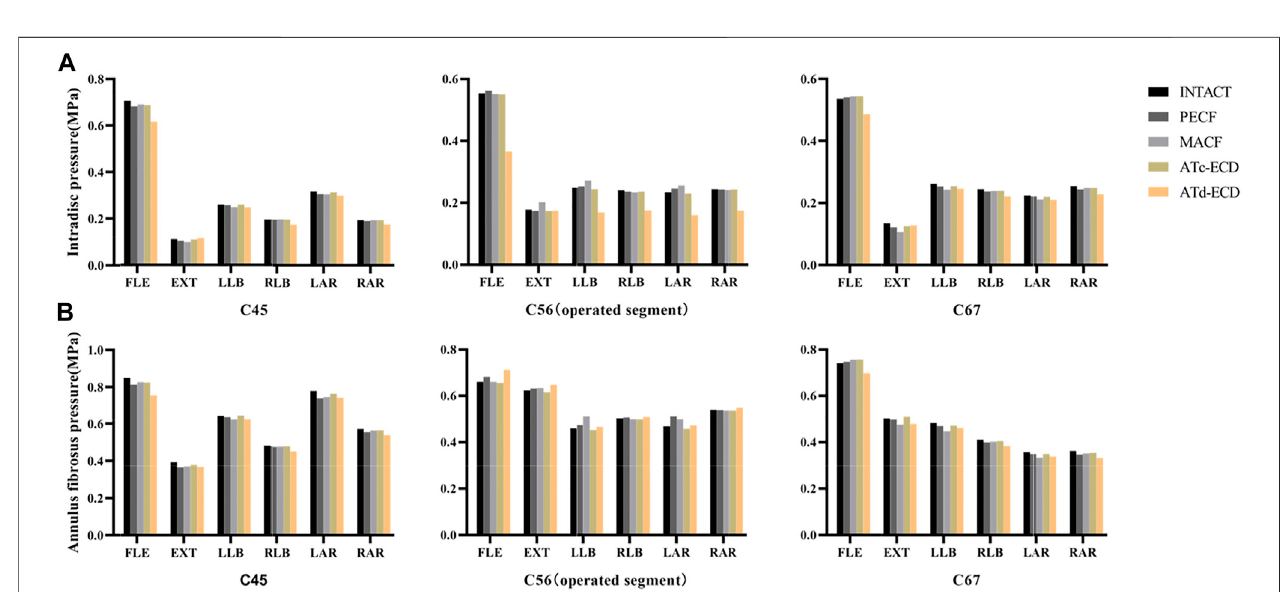
FIGURE 6 | The AFP and IDP of C4 – C5, C5 – C6, C6 – C7 in intact model and surgical models. (A) Intradiscal pressure; (B) Annulus fi brosus pressure. FLE, fl exion; EXT, extension; LLB, left lateral bending; RLB, right lateral bending; LAR, left axial rotation; RAR, right axial